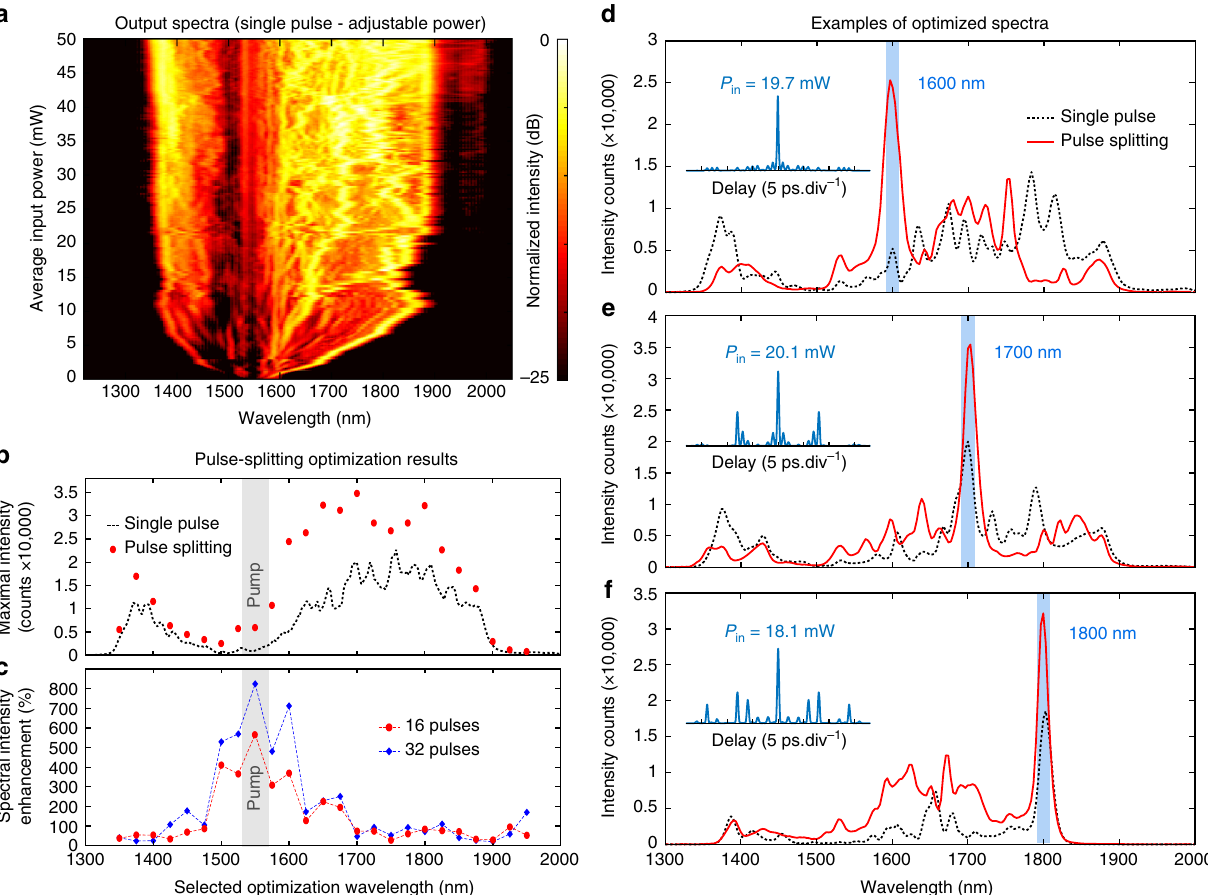
Fig. 3 Supercontinuum spectral intensity optimization at selected wavelengths. a Spectral intensity map measured at the highly-nonlinear fi bre output, generated by a single pulse seed as a function of its average power. b Maximal spectral intensity reached as a function of the selected optimization wavelength, considering either a single pulse seed case (dashed black line — i.e. the maximal intensity retrieved from panel a ), or using the pulse-splitting optimization technique (with up to 16 pulses — red circles) for the same power budget — see Methods. c Spectral intensity enhancement (relative to the single pulse seed case as a reference), for pulse-splitting performed with 16 (red dots) or 32 (blue diamonds) seed pulses. For reference, the input pump spectral location is shown as grey shadings in ( b ) and ( c ). d – f Examples of spectra obtained following intensity maximization at target wavelengths (blue shadings), using single pulse seeding (dashed black lines), or pulse-splitting optimization (red lines — with up to 16 pulses). The insets show the autocorrelation traces of the corresponding, optimal input pulse trains and average powers P